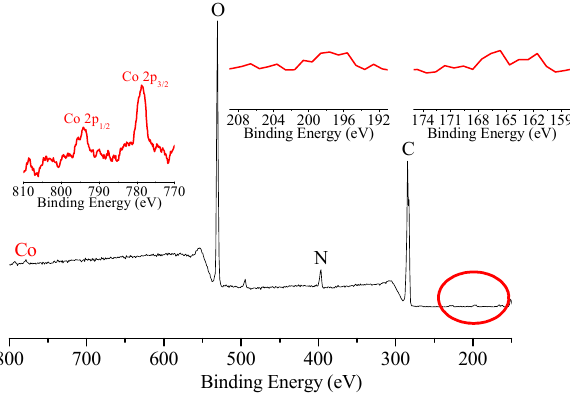
Figure 9. XPS of cross-section of CoPc@BC after catalytic oxidation. Left inset: detail of Co region, middle inset: detail of Cl region, right inset: detail of S region.